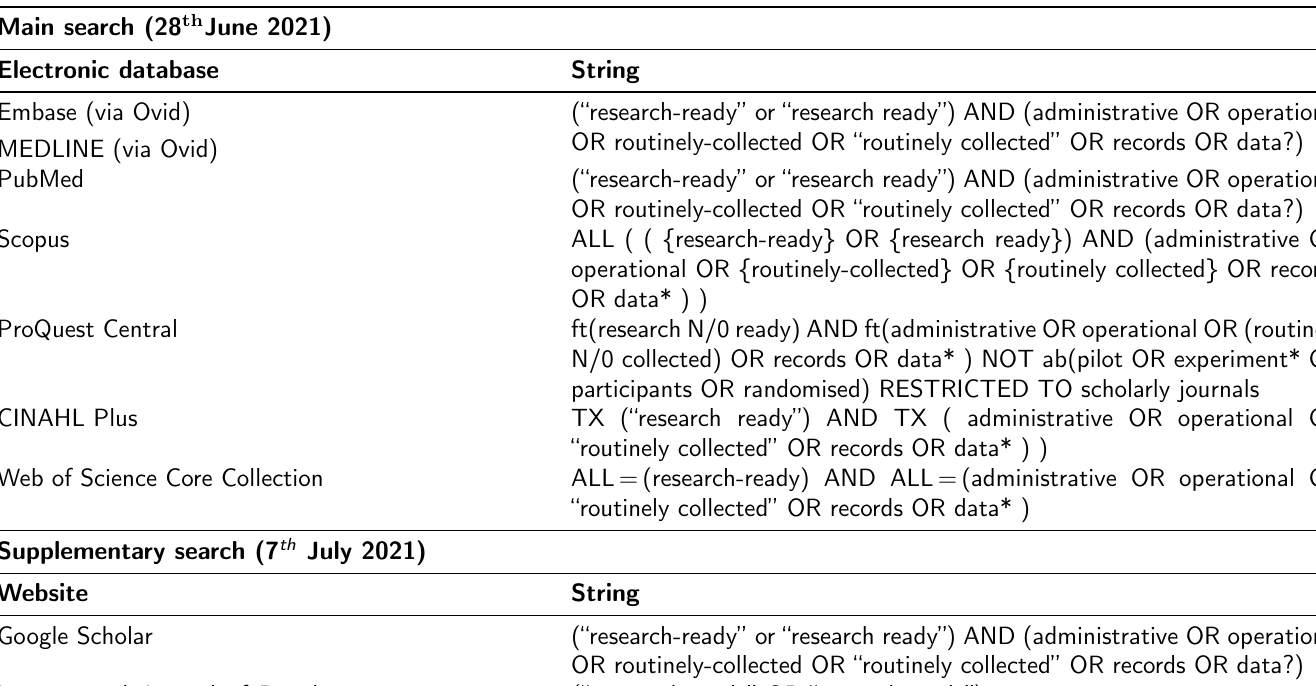
Supplementary Table 1: Search strings used in systematic